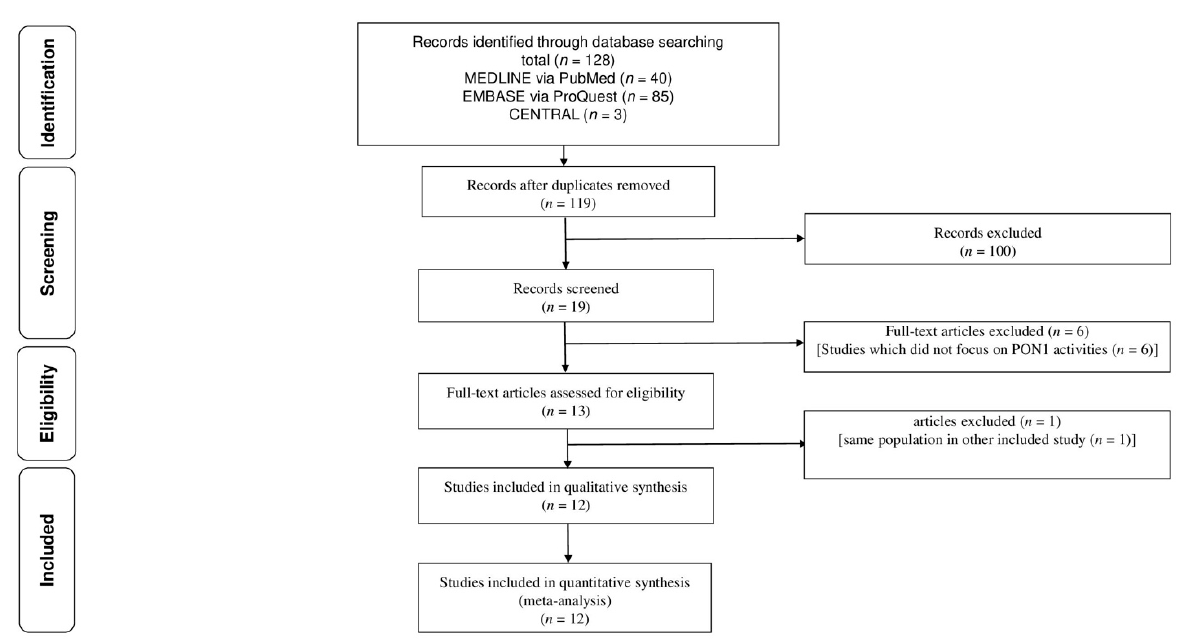
Figure 1. Flow of the selection of literature that reported the relationship of PON 1 with chronic obstructive pulmonary disease. PON1: paraoxonase 1.